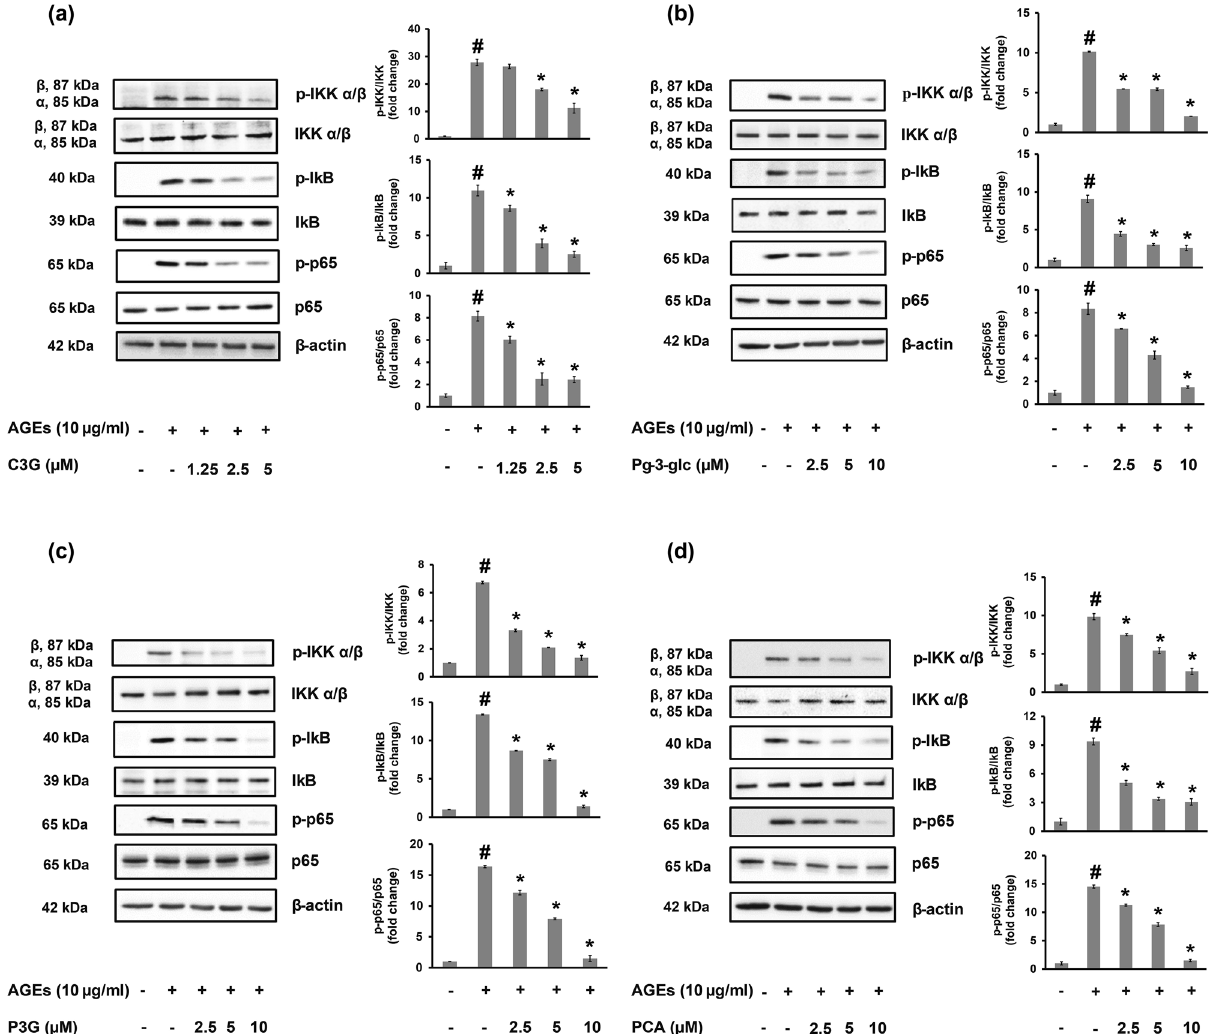
Figure 4. Effect of C3G, Pg-3-glc, P3G and PCA on AGEs activated NF-κB signaling pathways in HACs. The phosphorylation levels of IKK, IκB and p65 were measured by western immunoblotting analysis. The density of each band was analyzed using TotalLab TL120. Data are expressed as the average mean ± S.D. of triplicate experiments. # p < 0.05 compared to untreated group; * p < 0.05 compared to AGEs treated